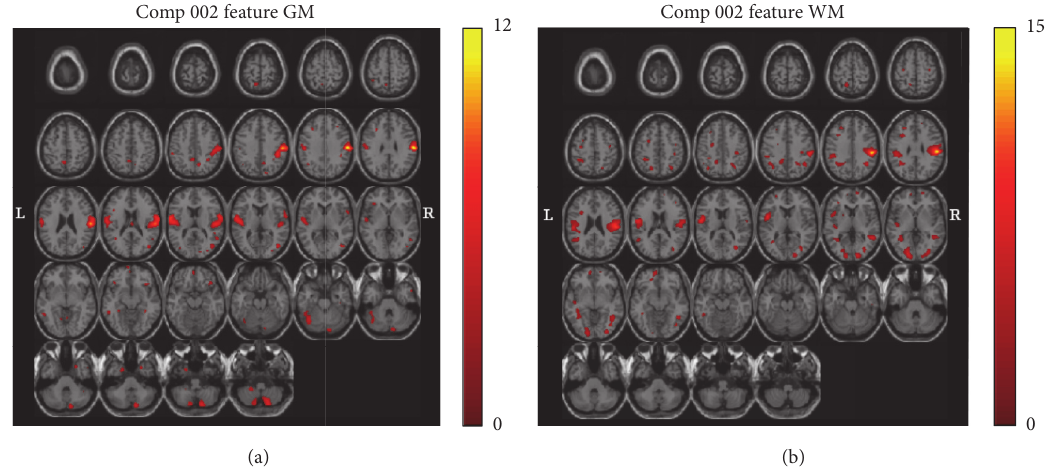
Figure 6: Significance maps with schizophrenia. The maps illustrating covariant decreases in the grey (a) and white matter volumes (b) in the two groups of schizophrenia based on their positive scale ( 𝑝 scale) in the positive and negative syndrome scale (PANSS), with a threshold of 24 for Component 2. The left of the plane is the left side of the brain. The color bar represents 𝑍 -scores.